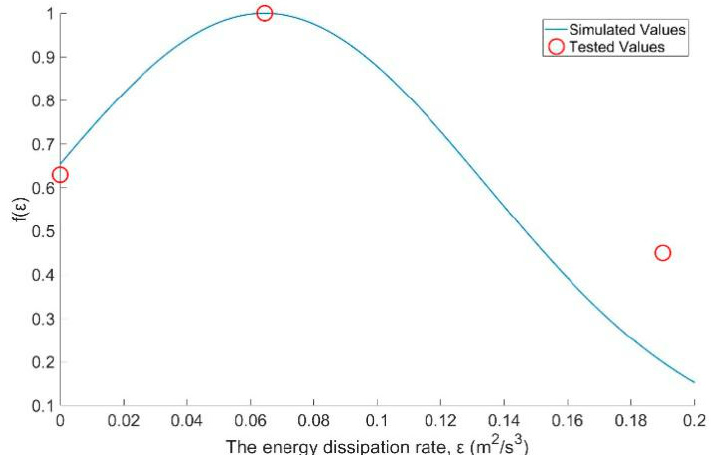
Figure 7 . Turbulence influence function diagram (the red circles are the values obtained from the current study).